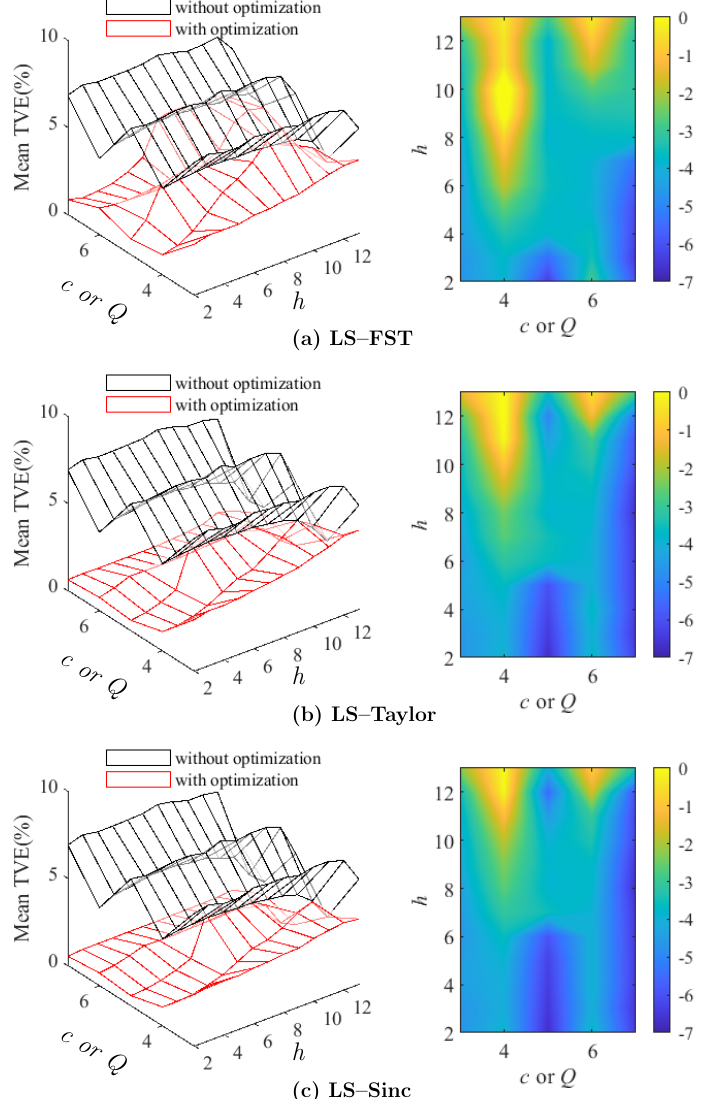
Figure 14. The left subplots show the relationship between the mean TVE of each harmonic and the time window length c (or signal model order Q ) for the ( a ) LS-FST, ( b ) LS-Taylor, and ( c ) LS-Sinc with and without the proposed optimization. The right subplots show the optimized TVE change, and the reference is the TVE before the optimization under the same parameter